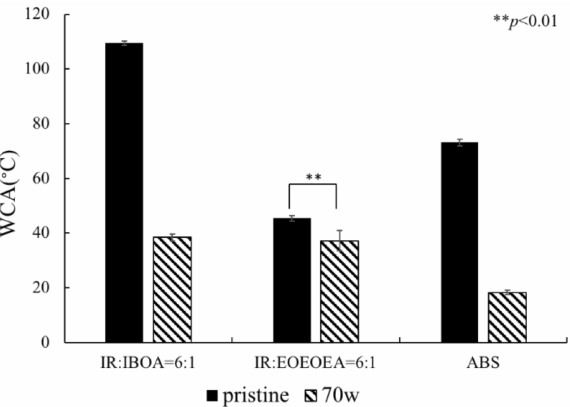
Figure 4. Contact angles of IR: IBOA = 6:1, IR: IEOEOEA = 6:1, and ABS. The power of plasma was 70 W/cm 3 , and the high-purity Ar with a flow rate of 3 slm is used as the working gas. (*) indicates a significant difference from each